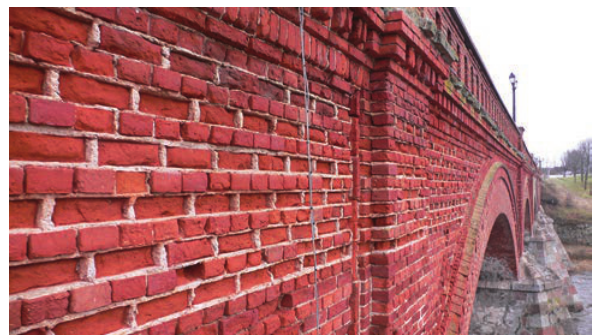
Fig. 5. Corroded and weathered bricks in wall surface from the upstream side